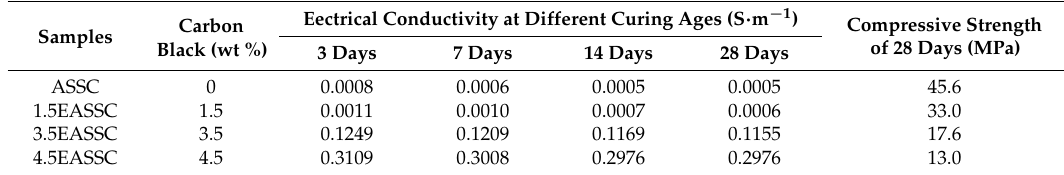
Table 2. Electrical conductivity and compressive strength of samples.